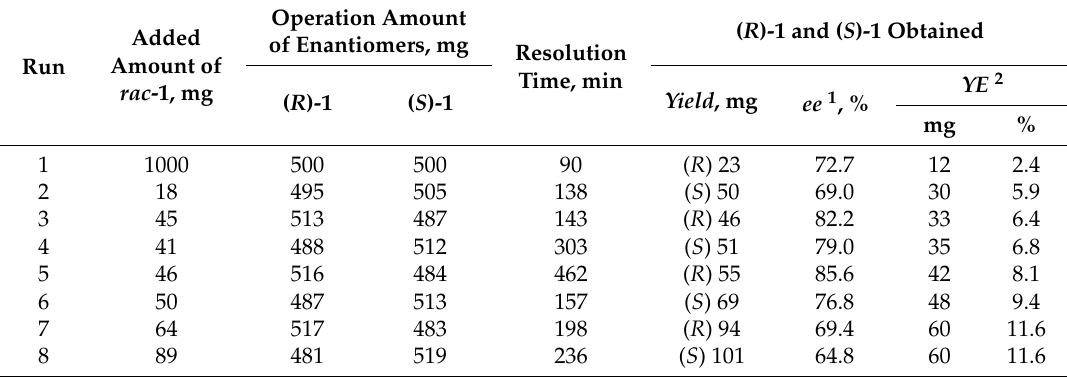
Table 2. Resolution by entrainment of rac -3-(3.4-dimethylphenoxy)propane-1,2-diol, rac - 1 in